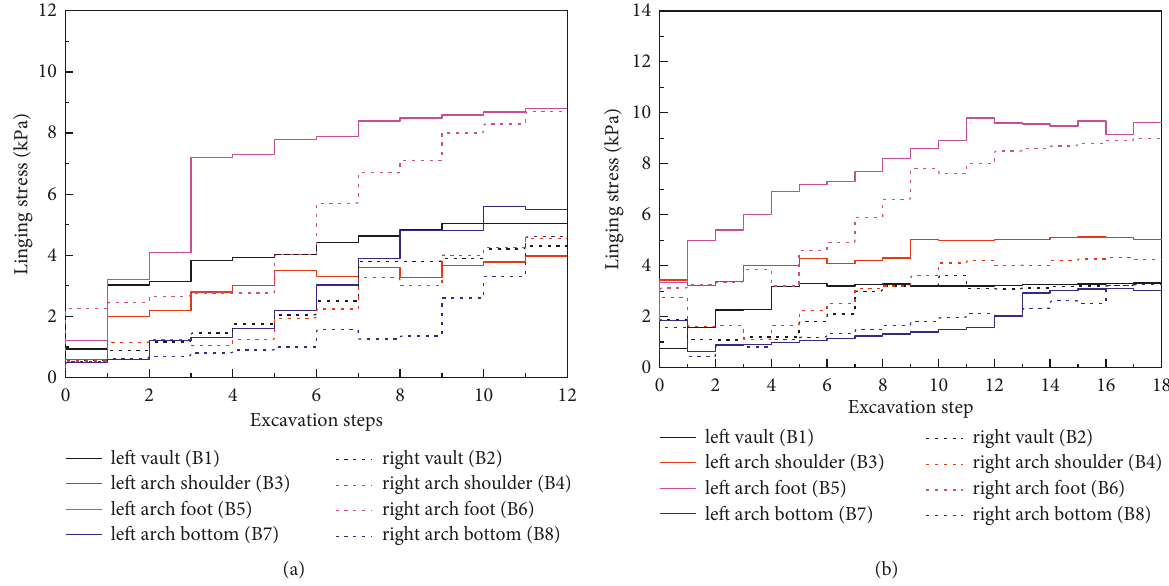
Figure 10: Lining stress variation of different excavation methods under no reinforcement forms. (a) Working condition 2. (b) Working condition